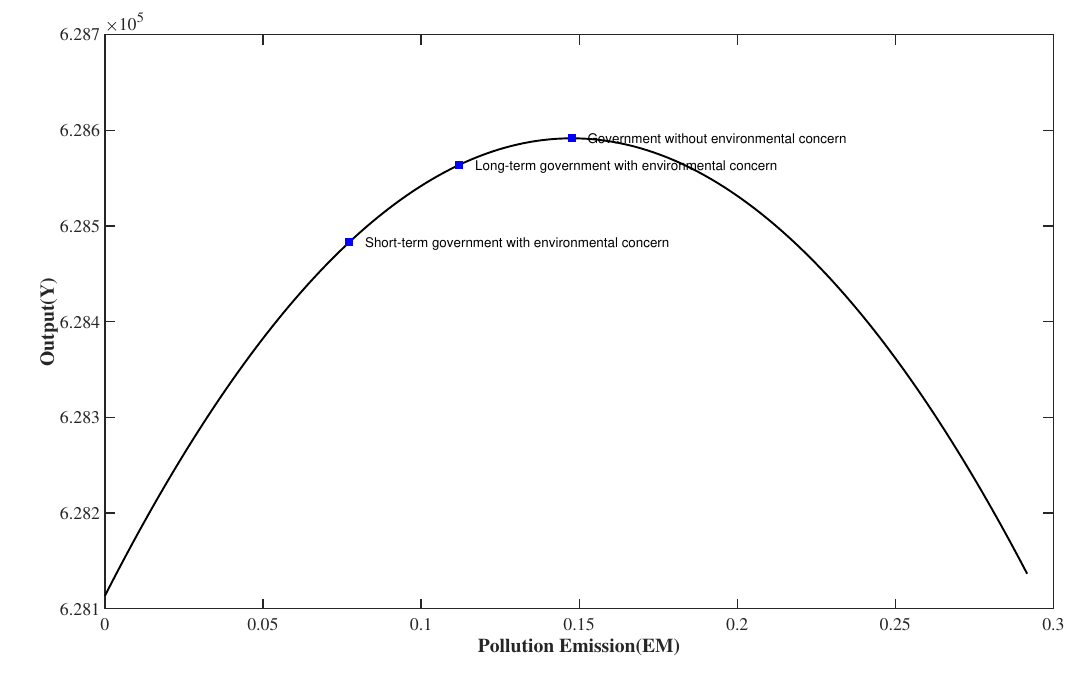
Figure 1. Optimal output and pollution emission